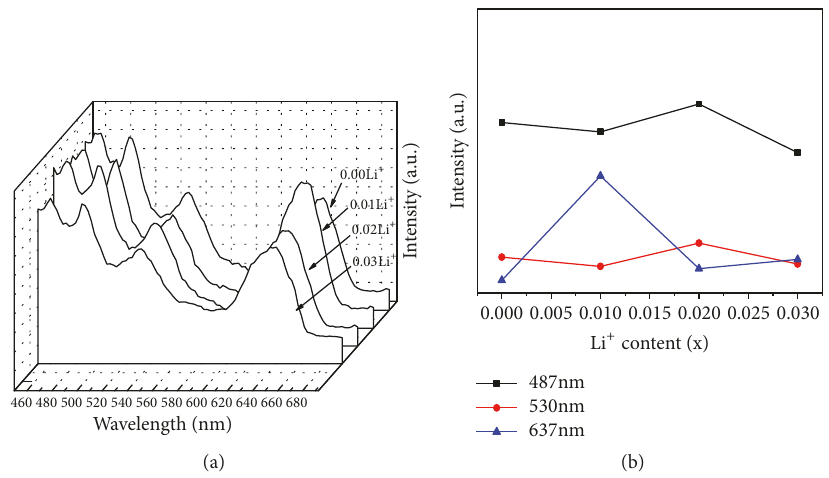
Figure 5: Emission spectra ( 𝜆 ex =335nm) of La 0.97 PO 4 :Bi 3+ 0.03 , Li + x (x = 0.00, 0.01, 0.02, 0.03) phosphors (a). The emissions intensity of 487 - x nm (blue), 530 nm (yellow), and 637 nm (red) as function of Li + doping concentration (red) (b).